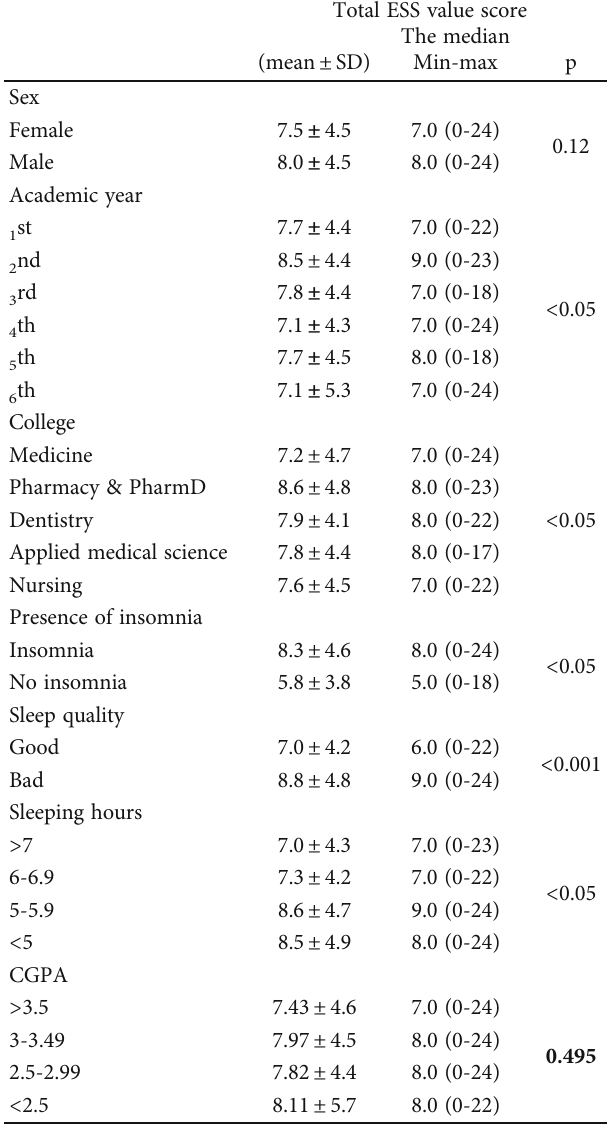
Table 4: Total ESS scores with students ’ characteristics. Table 4: represents the statistical analysis of the total ESS scores with students ’ characteristics analyzed by the independent samples t- test and ANOVA test.